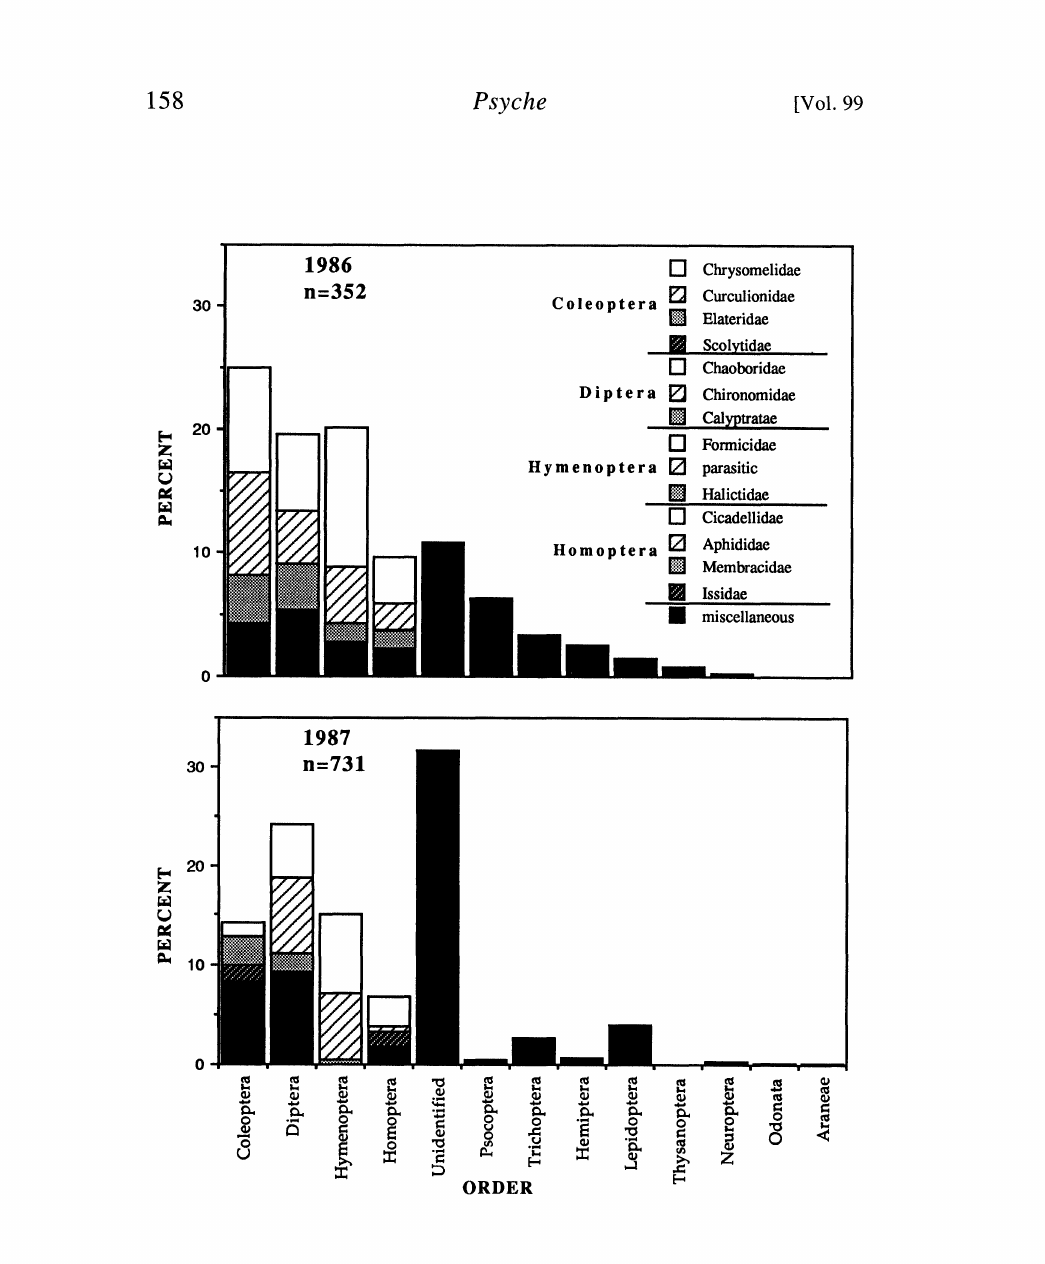
Fig. 1. Prey consumed in the field by M.